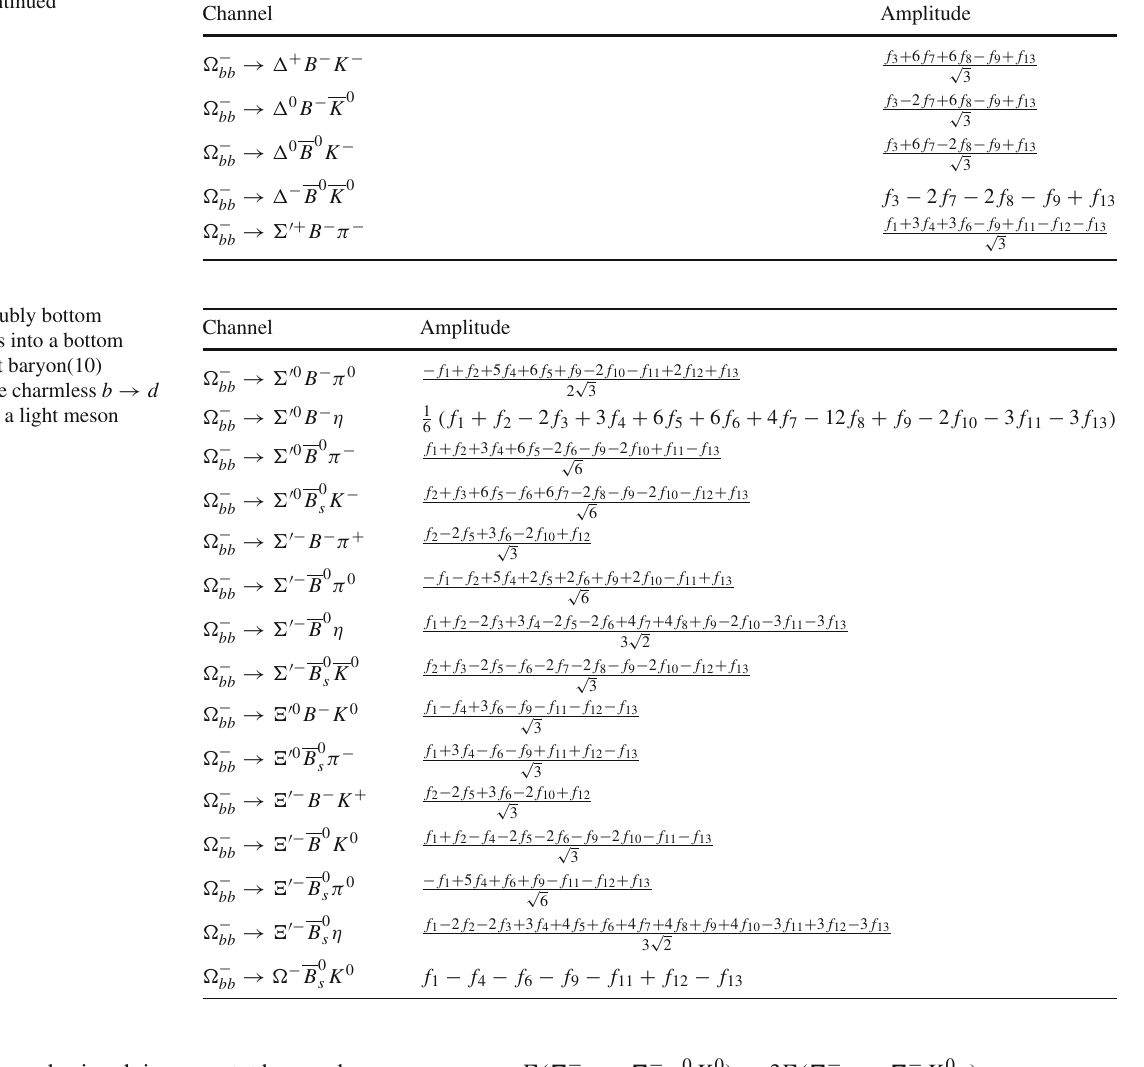
while decay modes involving a sextet baryon have → (cid:6) 0 π + ) = (cid:15)((cid:2) 0 (cid:15)((cid:2) 0 D − s bb b 0 π + ) = (cid:15)((cid:2) 0 → (cid:6) − D bb b